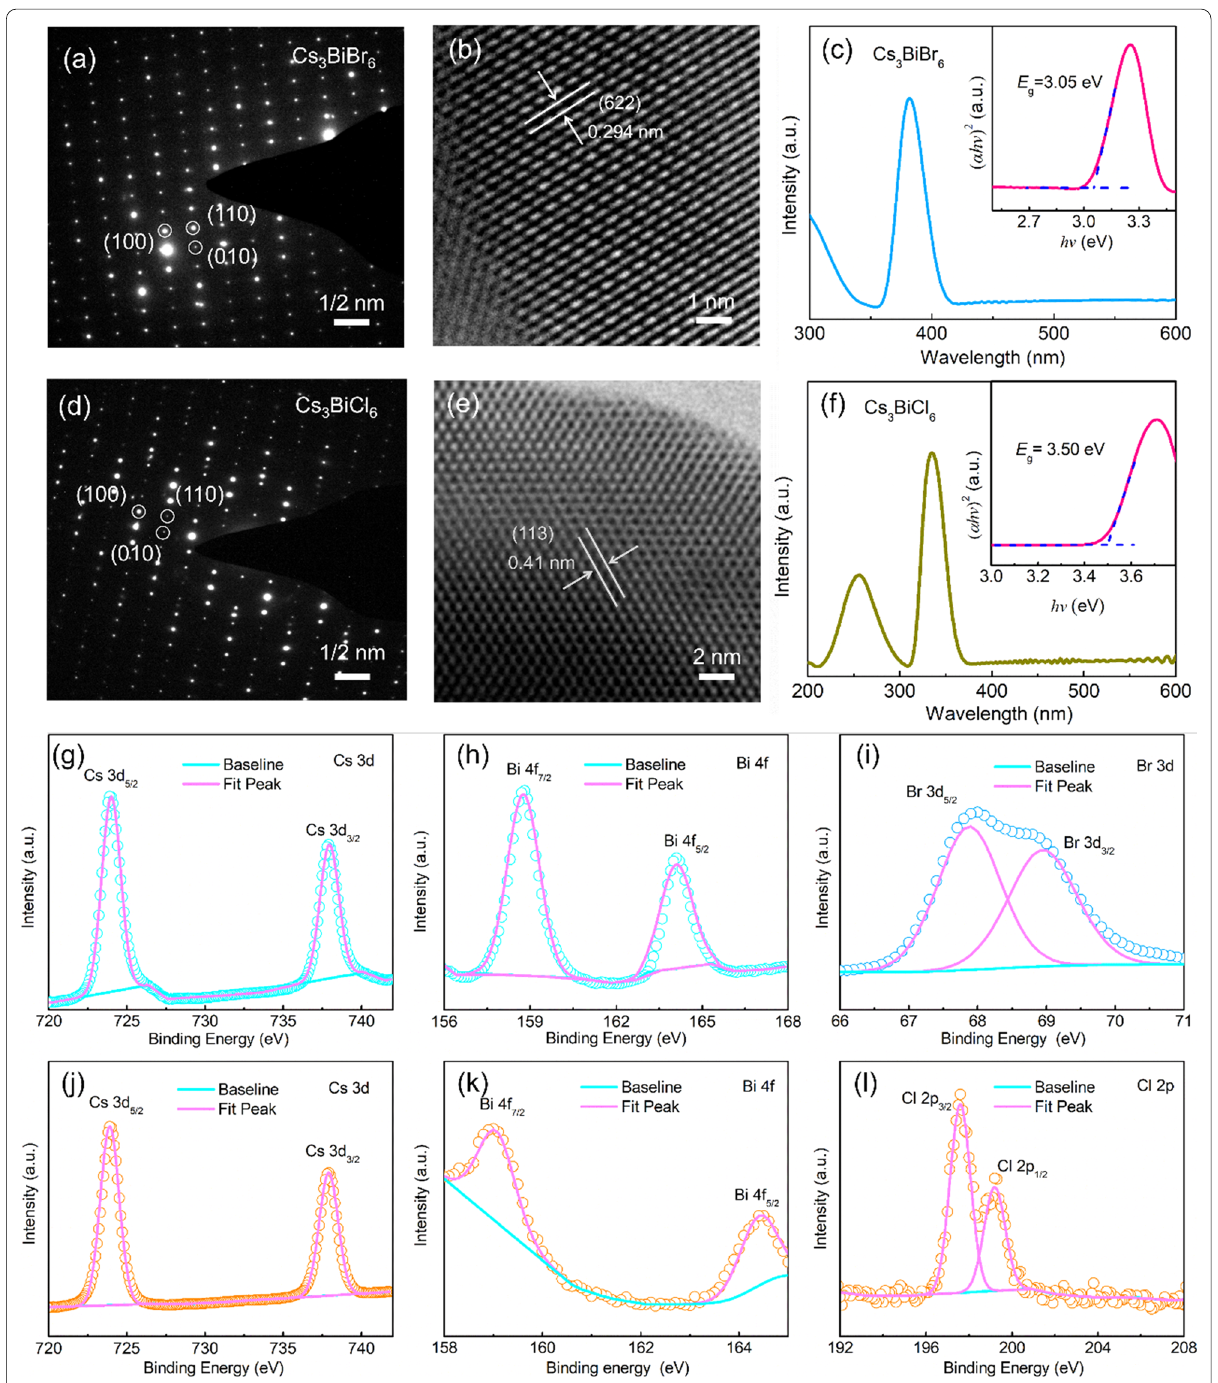
Fig. 2 a Selected area electron diffraction pattern of the Cs 3 BiBr 6 film. b HRTEM image of the Cs 3 BiBr 6 film. c UV–vis absorption spectra of the Cs 3 BiBr 6 film, the insert is the band gap value converted with the Tauc Plot method. d Selected area electron diffraction pattern of the Cs 3 BiCl 6 film. e HRTEM image of the Cs 3 BiCl 6 film. f UV–vis absorption spectra of the Cs 3 BiCl 6 film, the insert is the band gap value converted with the Tauc Plot method. XPS high-resolution scanning spectra of the of the Cs 3 BiBr 6 film: g Cs 3d, h Bi 4f, i Br 3d. XPS high-resolution scanning spectra of the of the Cs 3 BiCl 6 film: j Cs 3d, k Bi 4f, l Cl